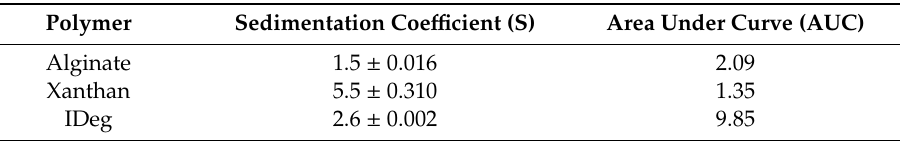
Table 1. Sedimentation coe ffi cient ( ± SD, obtained from linear regression of s against c) of Alginate (1 mg / mL), xanthan (1 mg / mL) and Insulin (3.6 mg / mL) at pH 7.0, 50 mM PBS after incubation at 4 ◦ C for 1 day. Analysis performed at 20 ◦